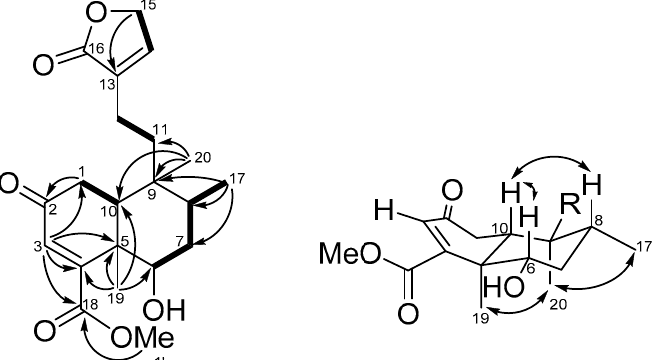
Figure 2. COSY (bold bond), selected HMBC (arrow), and NOESY (left-right arrow) correlations of compound 1.